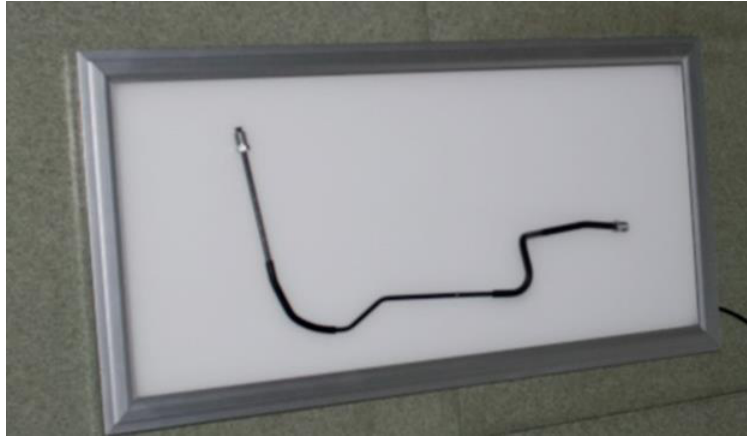
Figure 13. Precision validation experiment.